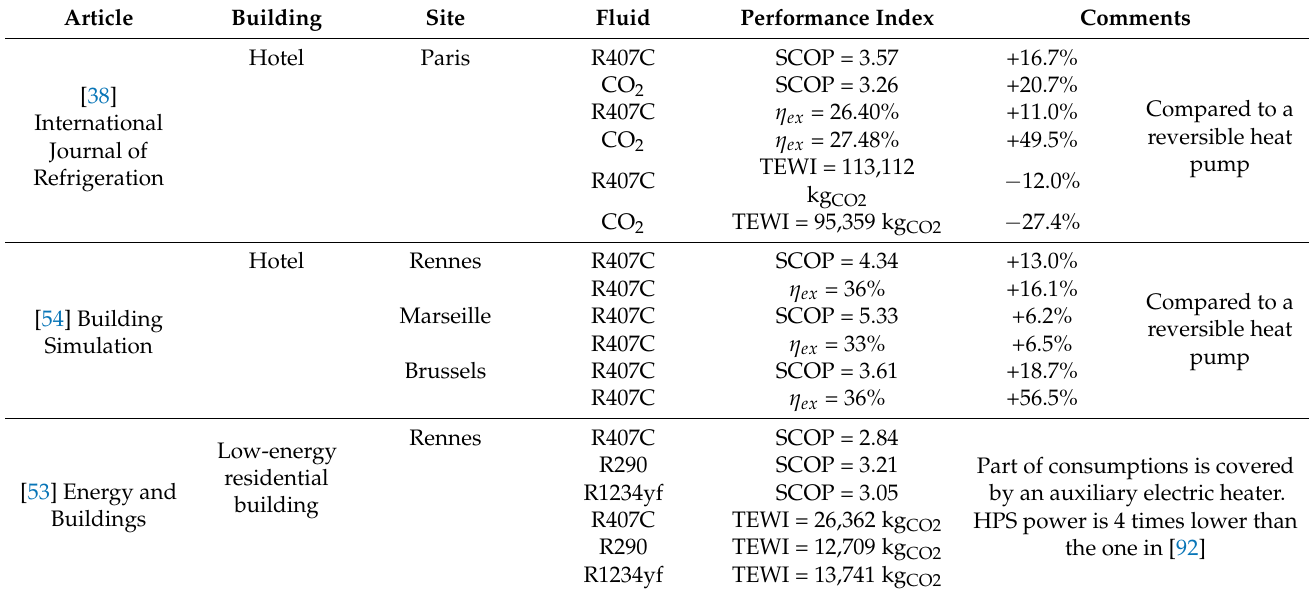
Table 12. Annual simulation results obtained with